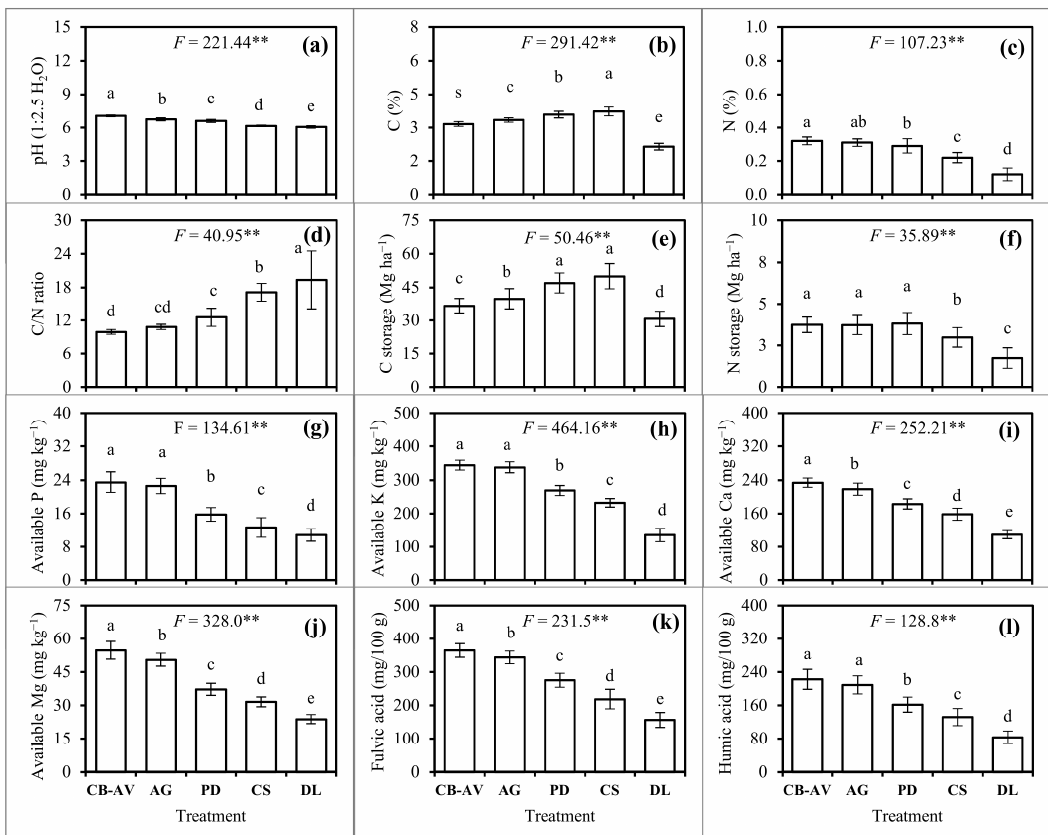
Figure 4. Mean values and standard deviation (SD) of soil chemical properties: pH (1:2.5 H 2 O) ( a ), C ( b ), N ( c ), C/N ratio ( d ), C storage ( e ), N storage ( f ), available P ( g ), K ( h ), Ca ( i ), Mg ( j ), fulvic acid ( k ), and humic acid ( l ) in the different tree species treatments. Results of the ANOVAs ( F test and p value) are given. Different letters after means within each treatment indicate significant differences by Duncan’s test ( p < 0.05). Note: ** P < 0.01. CB ‐ AV = natural forest stand of Carpinus betulus L. ‐ Acer velutinum Boiss.; AG = plantation of Alnus glutinosa (L.) Gaertn.; PD = plantation of Populus deltoides L.; CS = plantation of Cupressus sempervirens L. var. horizontalis (Mill.) Gord.; DL = degraded land without trees.